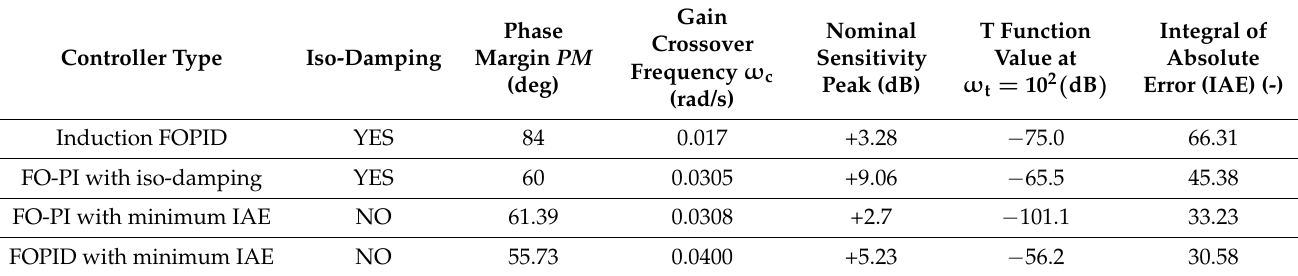
Figure 8. Comparison of error signals obtained using the different controllers designed for control- ling the BIS value—simulation results for the nominal patient 1.